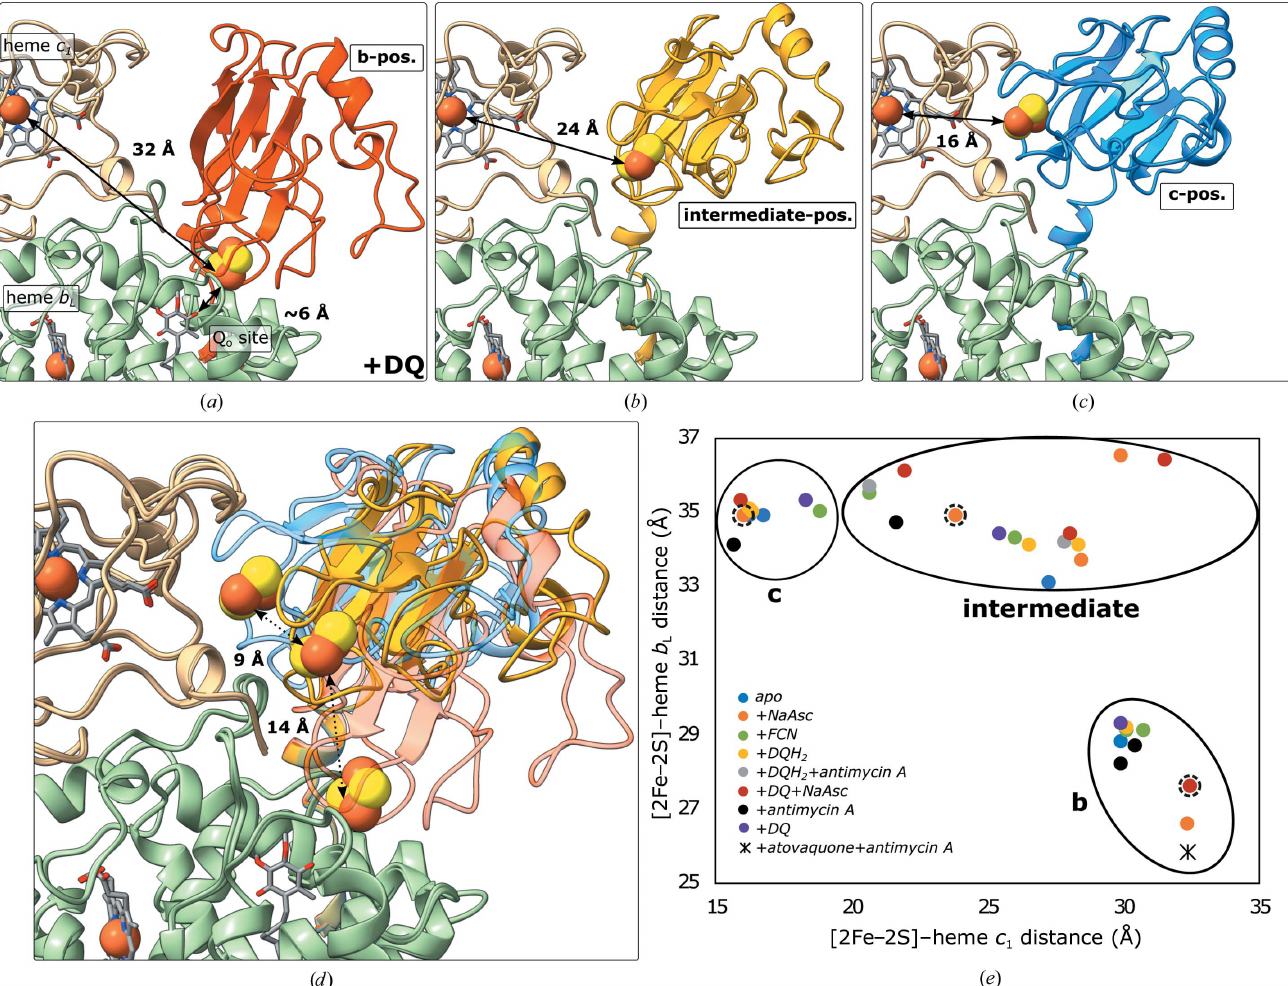
Figure 2 Typical b (red), intermediate (yellow) and c (blue) positions of the Rieske domain after focused 3D classification and refinement ( a , b , c ) and a superposition of the three models ( d ). The range of different positions of the Rieske domain in all samples is visualized in the plot of the distances between Fe2 in the [2Fe–2S] cluster and Fe of heme b L and heme c 1 , respectively ( e ). The three positions in ( a )–( d ) are marked by dashed circles in ( e